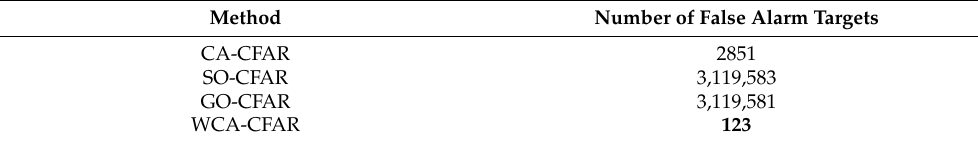
Table 3. Comparison of detection results of the correlation algorithm in the lake